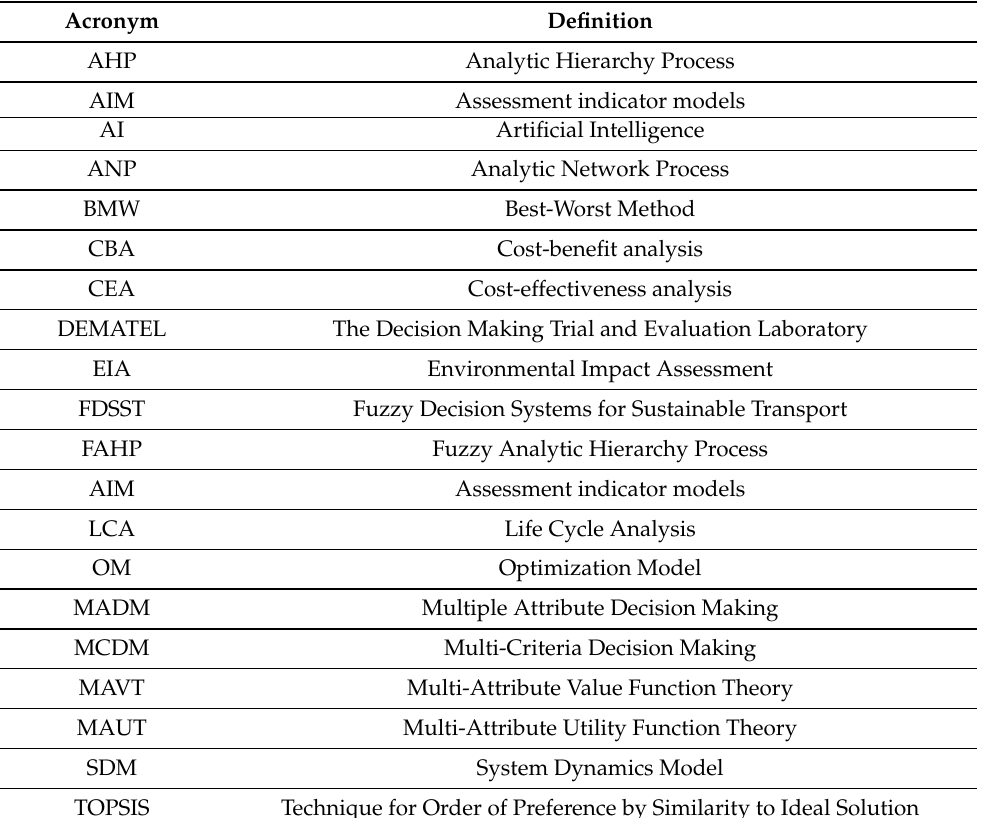
Table 2. List of acronyms.